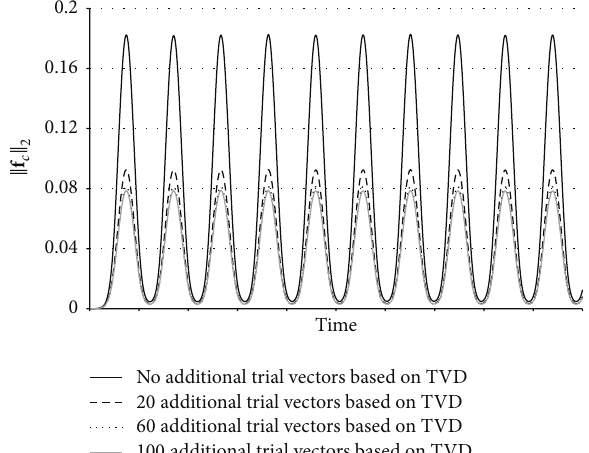
Figure17:TimeevolutionoftheEuclidiannormofthecontactforce vector.